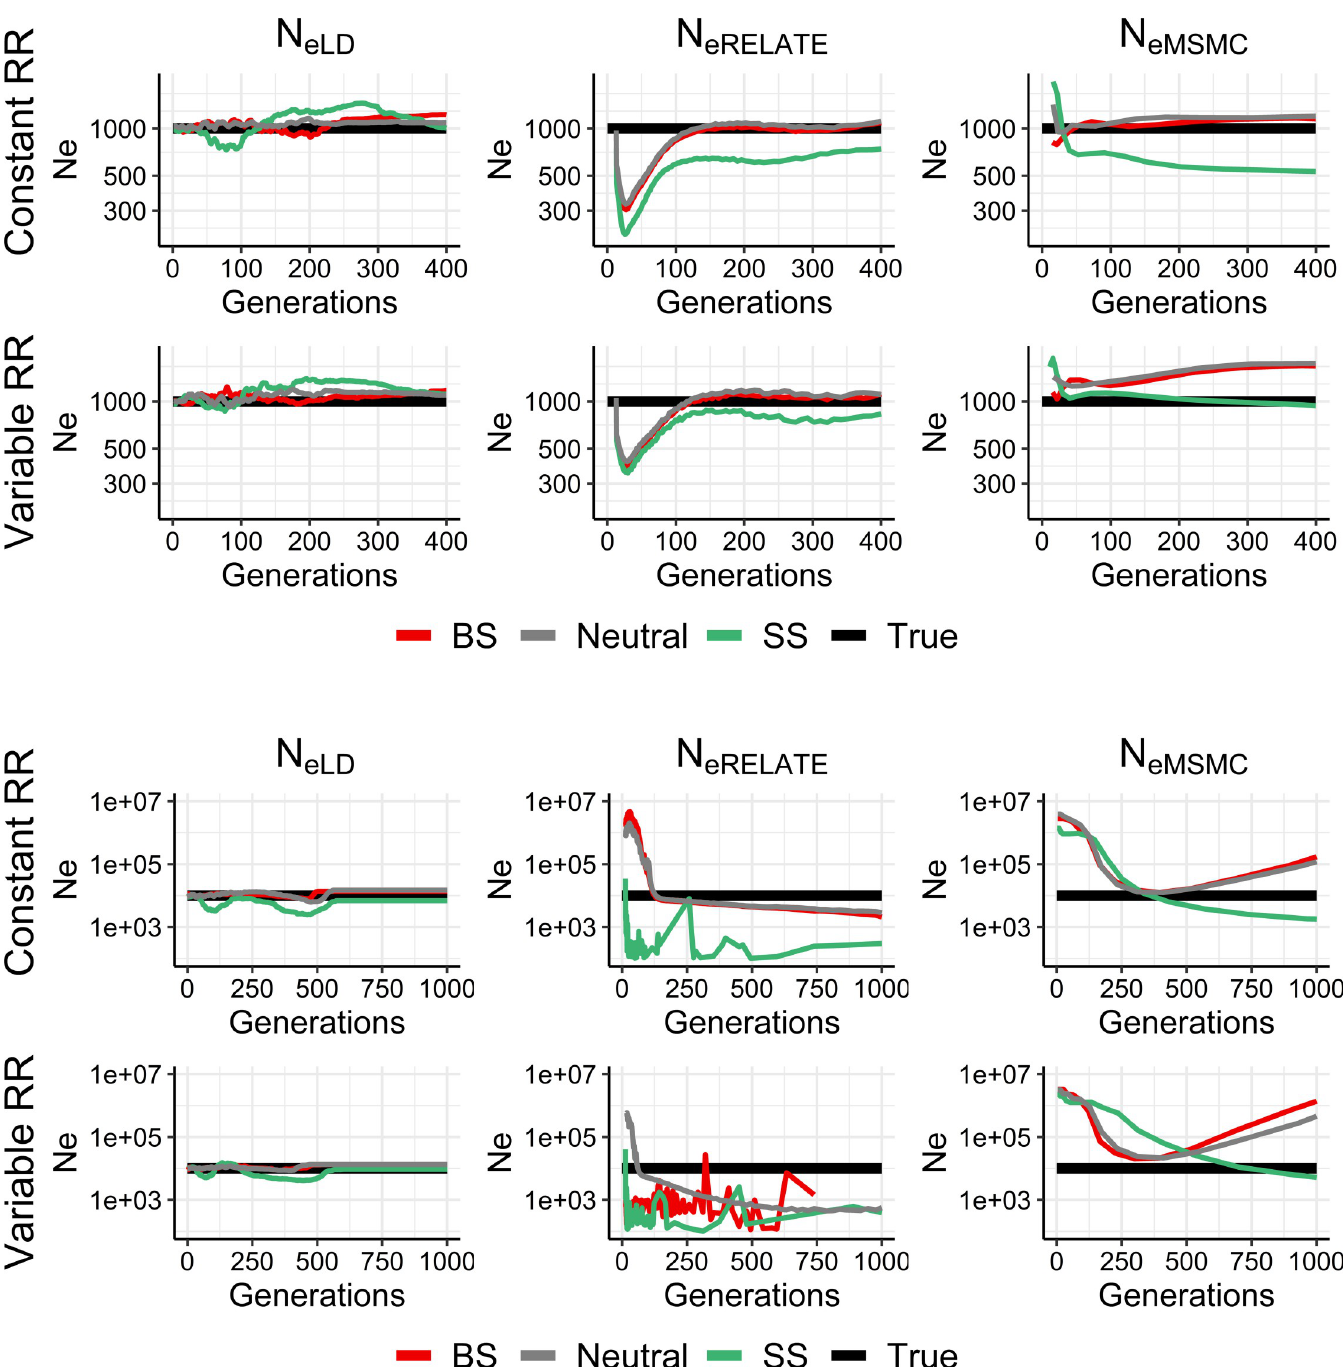
Fig 2. Estimates of historical effective population size from linkage disequilibrium ( N eLD , sample size n = 100 individuals), Relate ( N eRelate , n = 100) and MSMC ( N , n = 4) from the present generation (generation 0) back to 400 or 1,000 generations in the past. 100 replicates were run of simulations with constant eMSMC population size ( N ) under random mating and neutrality (grey), background selection (BS, red) or selective sweeps (SS, green), with constant (1 cM/Mb) or variable recombination rates ( RR ), and constant mutation rate μ = 10 − 8 or 10 − 9 mutations per base per generation for N = 1,000 or N = 10,000, respectively. The true simulated effective size from variance of family size ( N eVk = N ) is shown in